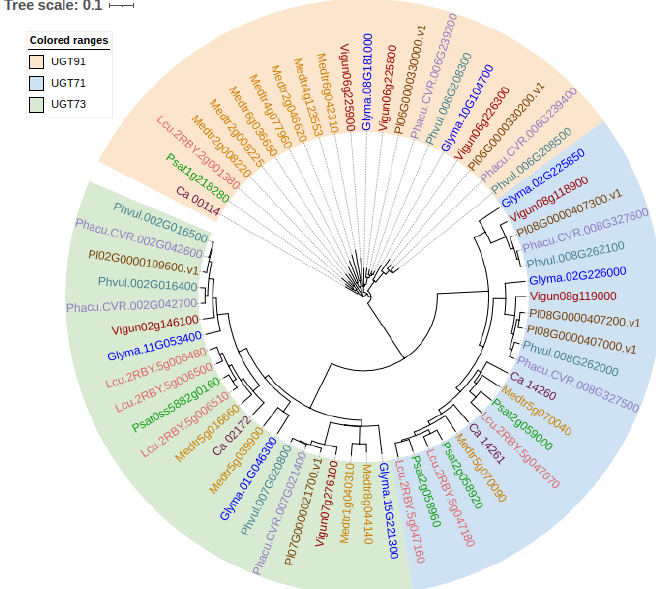
Figure 4. Neighbor-joining phylogenetic tree of uridine diphosphate-dependent (UDP) glycosyltransferases (UGTs) orthologues from pulse crop species. The amino acid sequences of Medicago